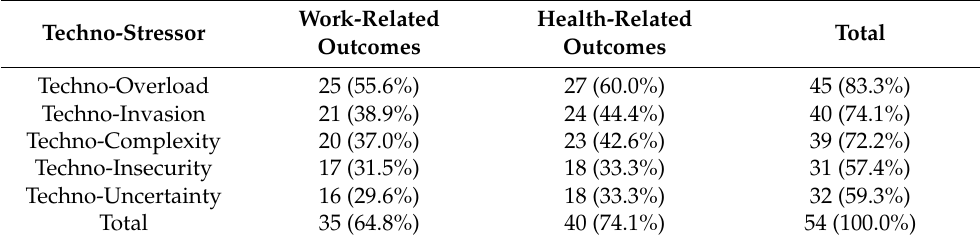
Table 3. Frequencies of techno-stressors, work- and health-related outcomes in quantitative studies ( n = 54) 1